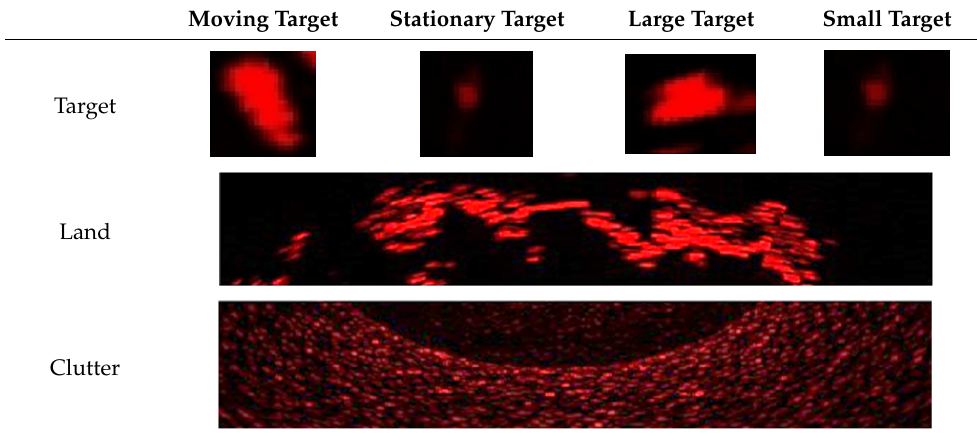
( b ) Figure 11. Characterizations of the radar PPI images dataset: ( a ) Examples of a navigation radar PPI image; ( b ) Multiple targets in the same anchor box. In order to avoid training over-fitting and overlap of the training set, test set, and validation set data, the following method is adopted. The dataset D is divided into two mutually exclusive sets: a training set S and test set T. When dividing, it is ensured that the data distribution is balanced, and the data is sampled by hierarchical sampling (the dataset in this paper is hierarchically sampled according to the scene). The specific method is that there are m 1 positive samples and m 2 negative samples in the data, and the ratio of S to D is p , and then the ratio of T to D is 1 − p . Positive samples in the training set can be obtained by sampling m 1 × p from m 1 positive samples, and m 2 × p samples are taken as the negative samples in the training set from the m 2 negative samples, and the rest are used as the samples in the test set. In order to solve the problem of an inconsistent picture size and pixels, the size of PPI images is adjusted to 416 × 416. Then, the targets’ location is anchored according to the AIS information. The problem of inaccurate labeling of several targets due to a close distance, i.e., an anchor box containing multiple targets, should be avoided. When label- ing such targets, the picture should be enlarged and the local pixels of the picture ex- panded, and it should be ensured that there is only one target in an anchor box. 3.2. Marine Target Detection Results of Faster R-CNN and